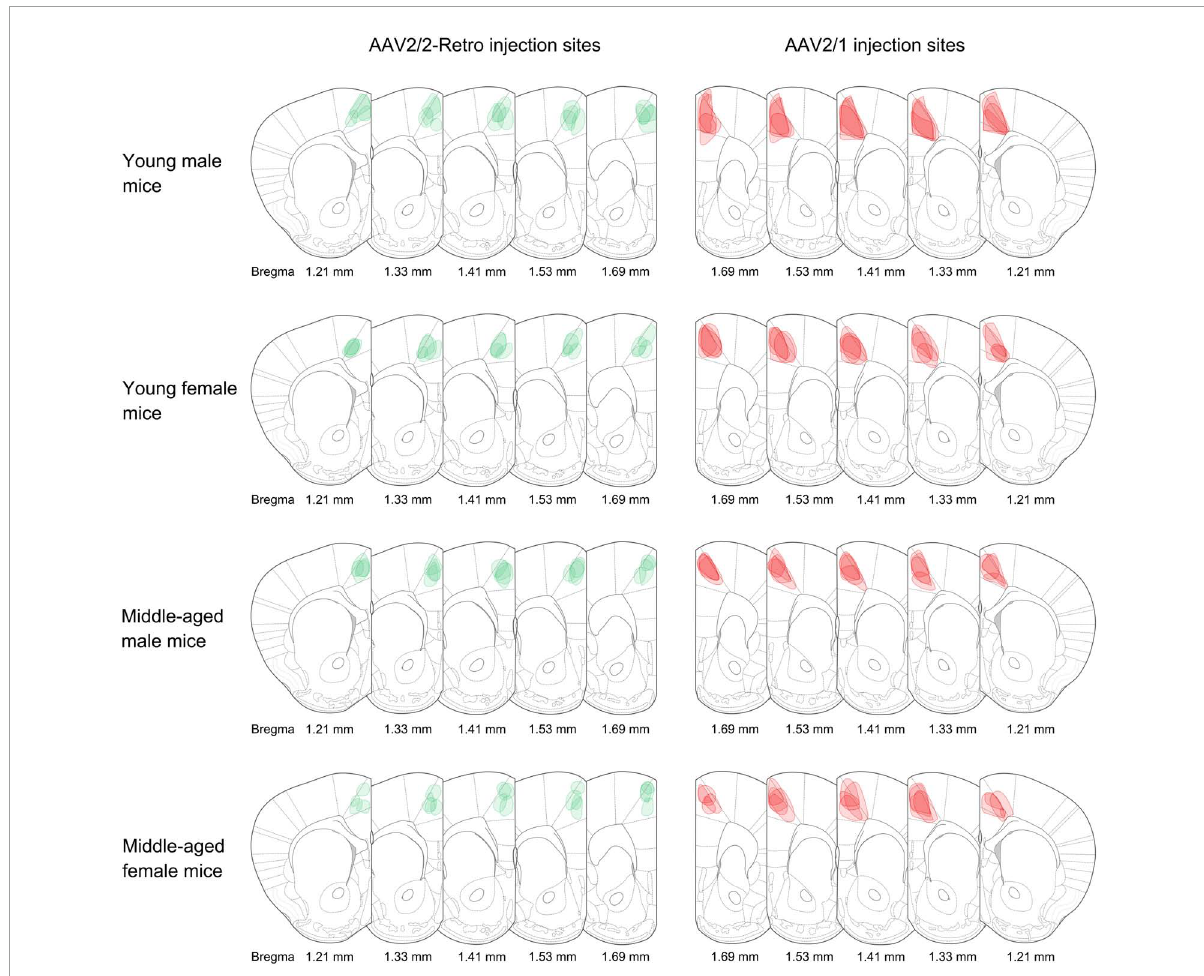
FIGURE1 Adeno-associated virus (AAV) injection sites. The schematic depicts the actual injection site of the virus into the rACC. The boundaries of the green and red colors represent the range of retrograde non-transsynaptic (AAV2/2-Retro-hSyn-EGFP) and anterograde monosynaptic (AAV2/1-hSyn-CRE-mCherry) AAV. The corresponding bregma value of brain slices is marked below. The image represents n = 4 animals.